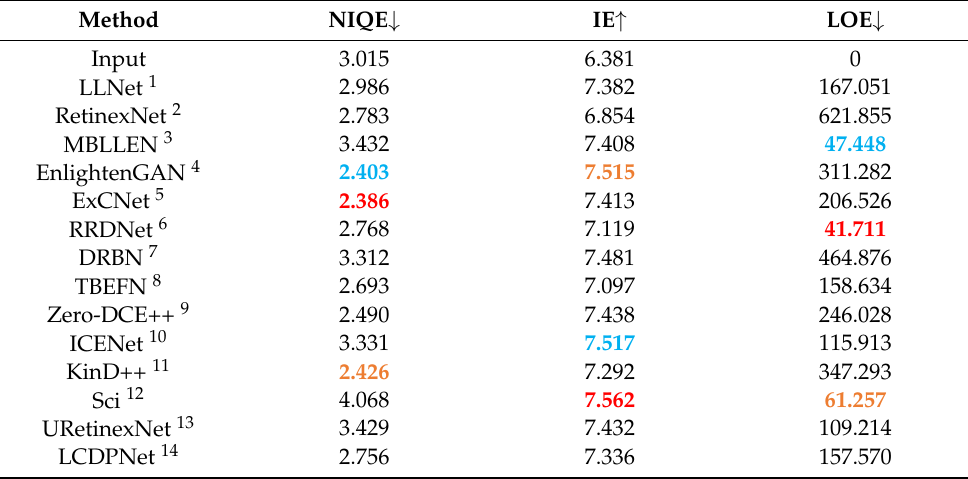
Table 4. Quantitative comparison of the LIME dataset (Unpaired Dataset) according to NIQE, IE, and LOE. The best result is bold in red , the second result is bold in blue , and the third result is bold in yellow .